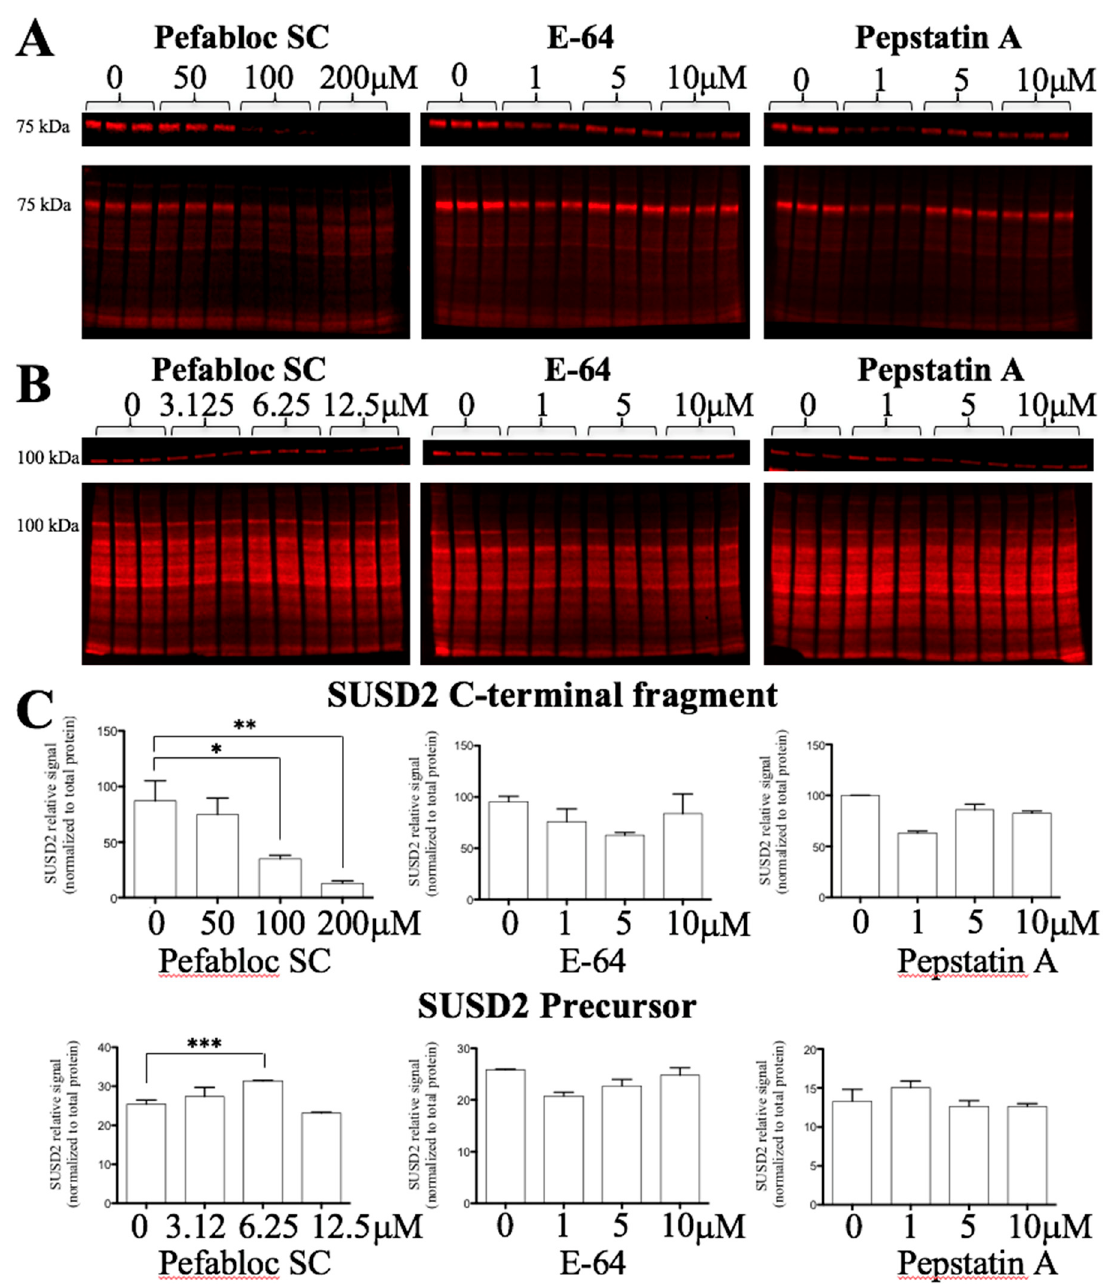
Figure 4. Fluorescence imaging of pulse ‐ chase analysis (top) and REVERT total protein stain (bottom) of ( A ) SUSD2 C ‐ terminal fragment or ( B ) SUSD2 precursor run in triplicate. MDA ‐ MB ‐ 231 ‐ SUSD2 ‐ SNAP cells were treated with SNAP ‐ Cell Block followed by incubation with Pefabloc SC for 24 ( A ) or 6 ( B ) hours. Lysates were harvested and labeled with SNAP ‐ surface 682 fluorophore. Proteins were separated by gel electrophoresis, transferred to a membrane, and imaged using LI ‐ COR Odyssey Fc Imager. After pulse ‐ chase imaging, membranes were stained with REVERT total protein stain (LI ‐ COR) and imaged using LI ‐ COR Odyssey Fc Imager. ( C ) Pefabloc SC inhibits cleavage of SUSD2 and increases the amount of precursor. Quantification of results from ( A and B ) was performed by using the LI ‐ COR Image Studio Software. * indicates p ‐ value < 0.05, ** indicates p ‐ value < 0.01, and *** indicates p ‐ value < 0.001.